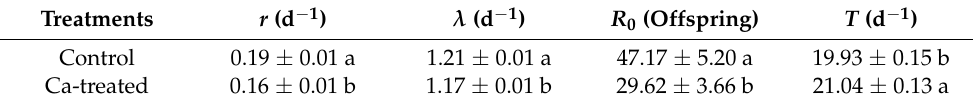
bean Table 2. The population parameters of Frankliniella occidentalis fed on control and Ca-treated kidney